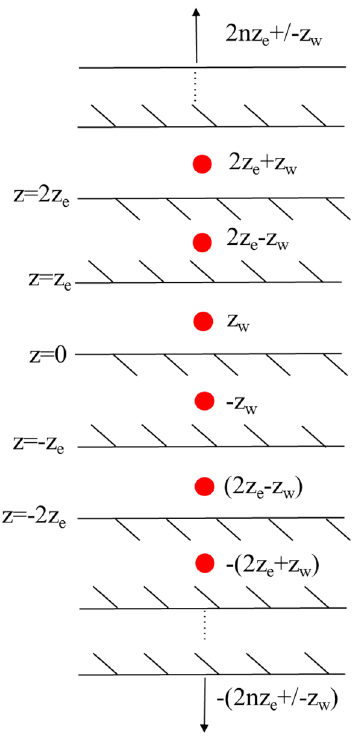
Figure 5. Schematic diagram of mirroring principle of closed boundary